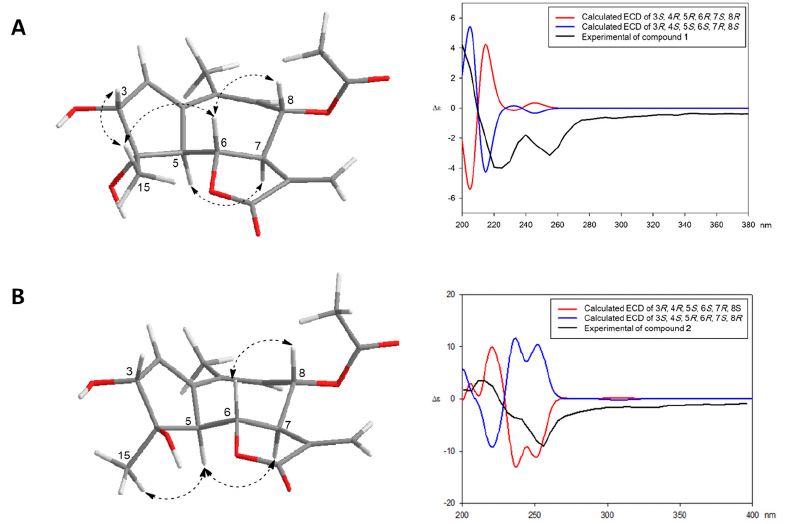
Figure 3. Key NOESY correlations and comparison of experimental and calculated ECD spectra of compounds 1 ( A ) and 2 ( B ).